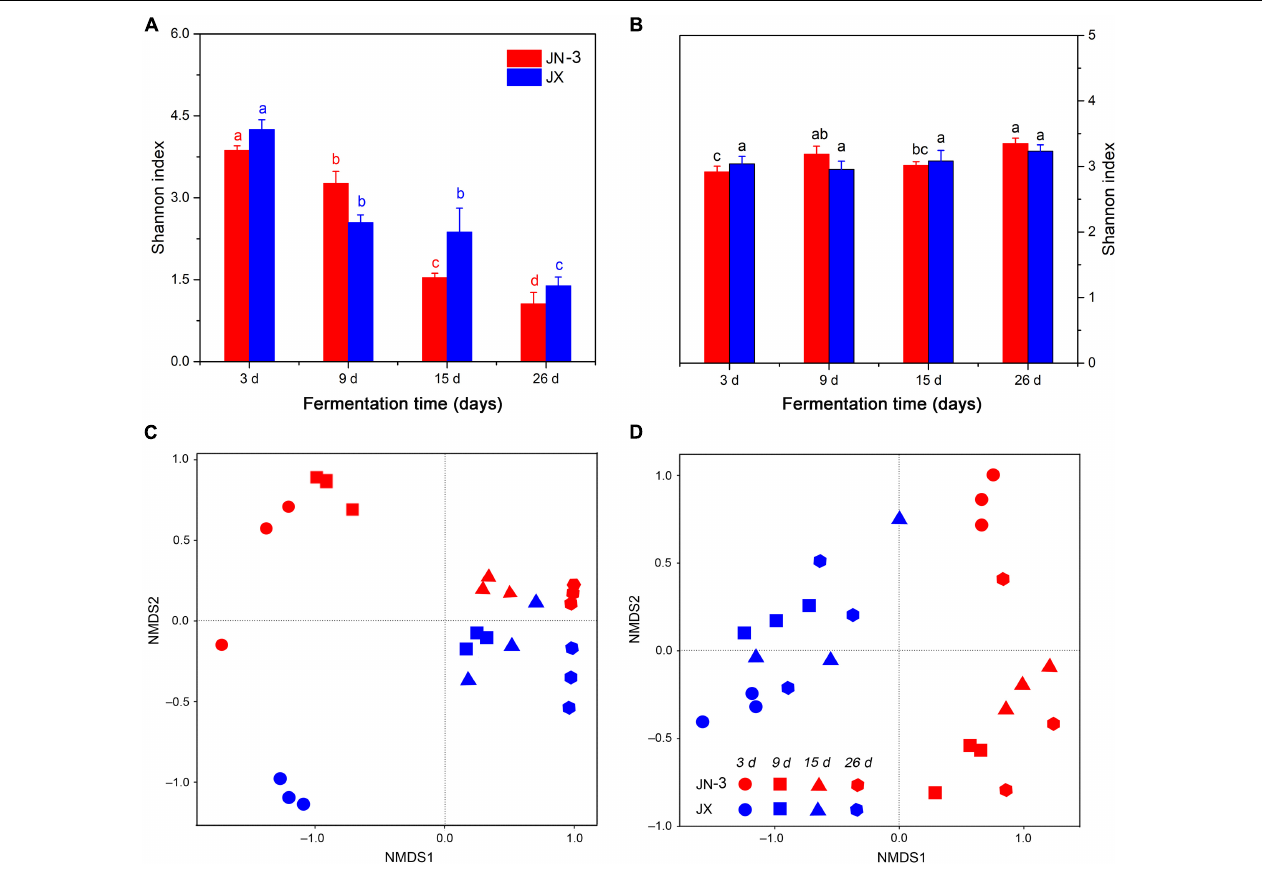
FIGURE 3 | Changes in microbial alpha diversity (Shannon index) [ (A) , bacteria; (B) , fungi] and beta diversity (NMDS) [ (C) , bacteria; (D) , fungi] of fermented grains in one waxy (JN-3) and one non-waxy sorghum (JX). Different letters indicate significant differences (ANOVA, P < 0.05) amongst different fermentation times for the same sorghum